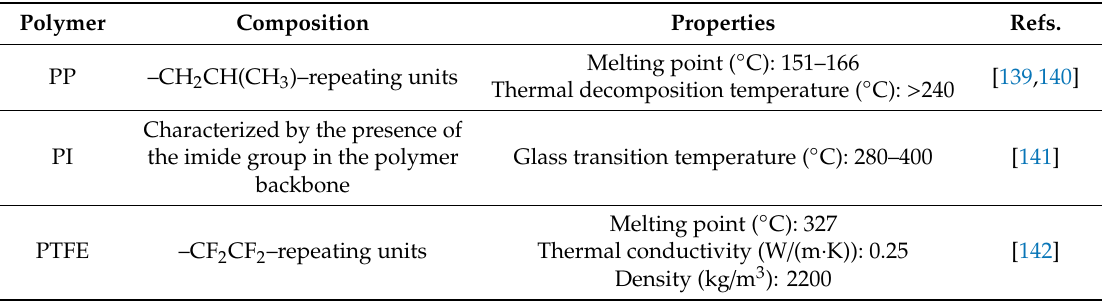
Table 7. The composition and properties of polypropylene (PP), polyimide (PI), and polytetrafluoroethylene (PTFE).